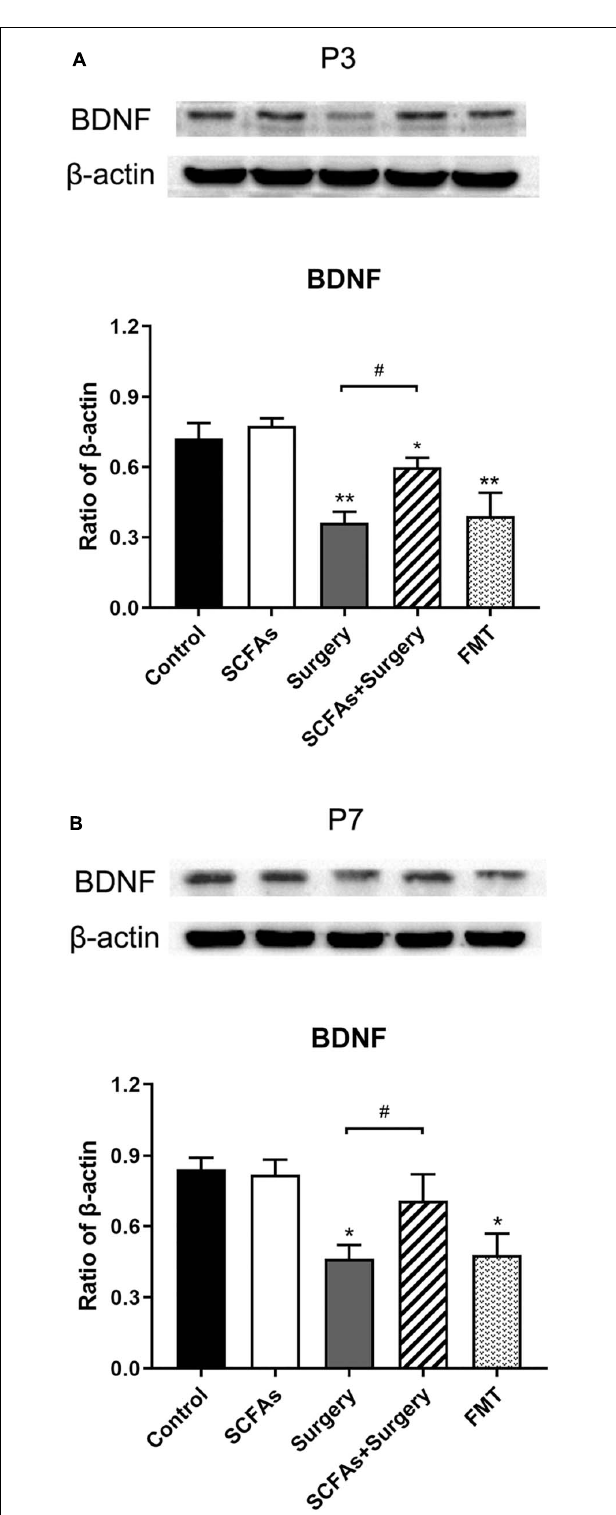
FIGURE 8 | BDNF protein expression was significantly downregulated following surgery procedure and fecal microbiota transplantation compared with the nonsurgical control group on postoperative or post-transplantation